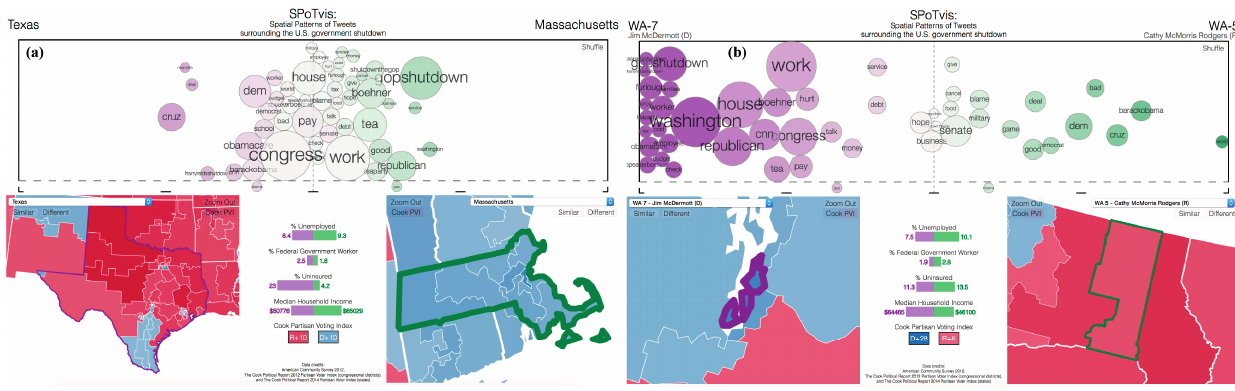
Figure 7. A blame game at play. ( a ) SPoTvis comparison of Texas and Massachusetts; ( b ) comparison of Washington 7 and Washington